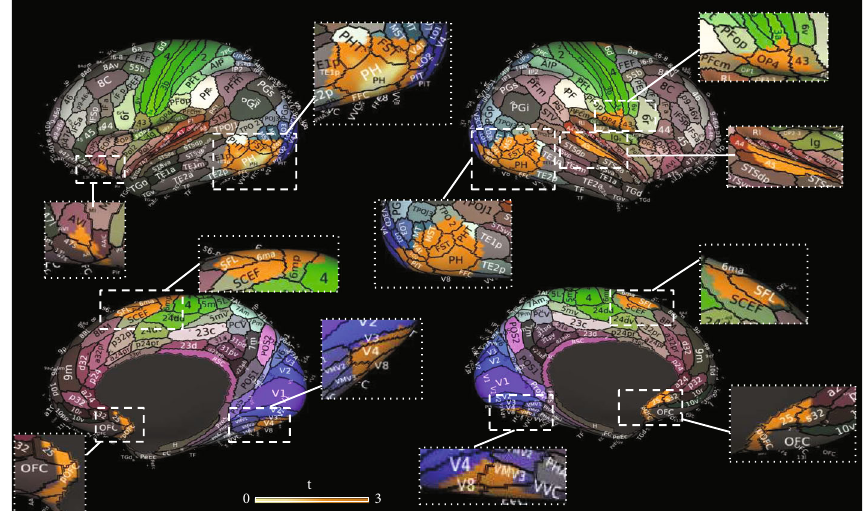
Figure 5: Anatomical mapping of o ff -target results. Qualitative overlap between the Glasser Atlas and the BOLD changes outside the stimulated areas (orange) shows changes in the primary and secondary visual areas, auditory cortex, subgenual cingulate cortex, and